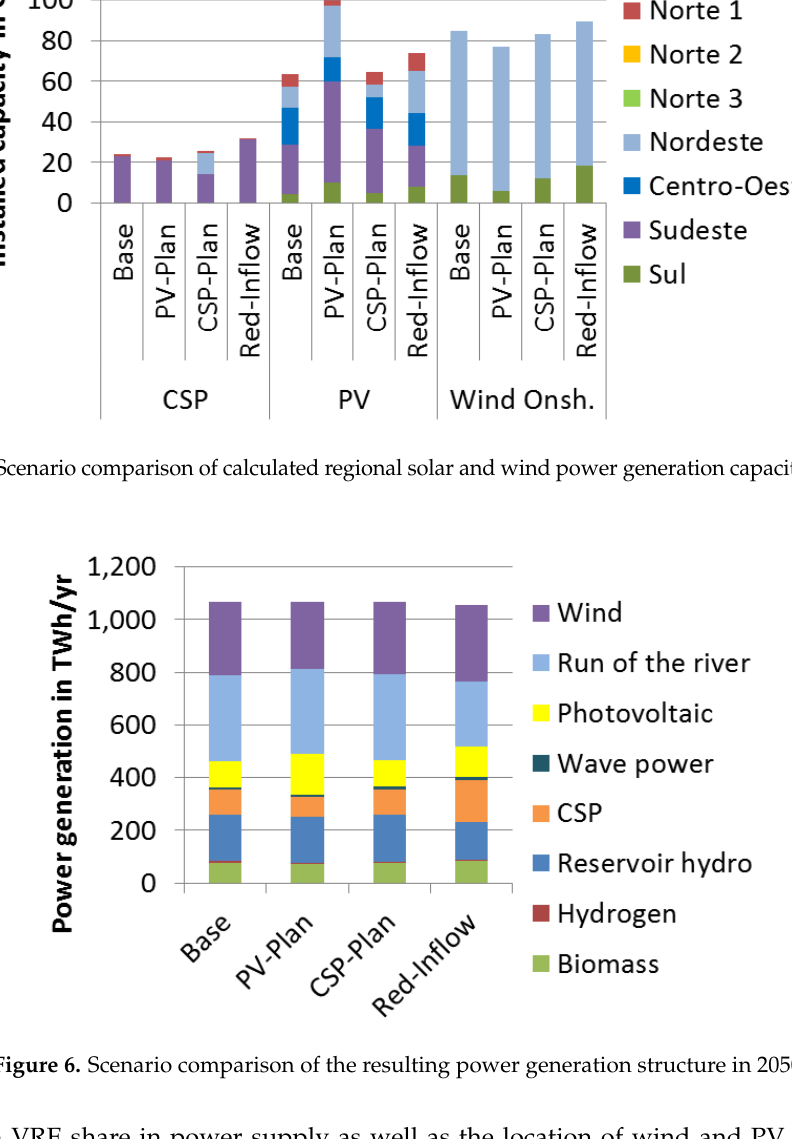
Figure 5. Scenario comparison of calculated regional solar and wind power generation capacities in 2050.